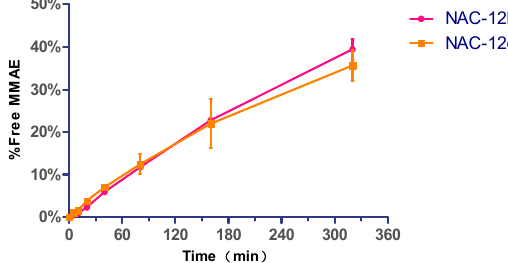
Figure 5. Cathepsin B reactivity for MMAE release. Typical time course of MMAE cleaved from N -acetyl- L -cysteine (NAC) conjugates based on VA and VC dipeptides. The enzyme-to-substrate ratio was 1:1000. Error bars represent standard deviation from three independent experiments (triplicates). Data are shown as mean ± SD.